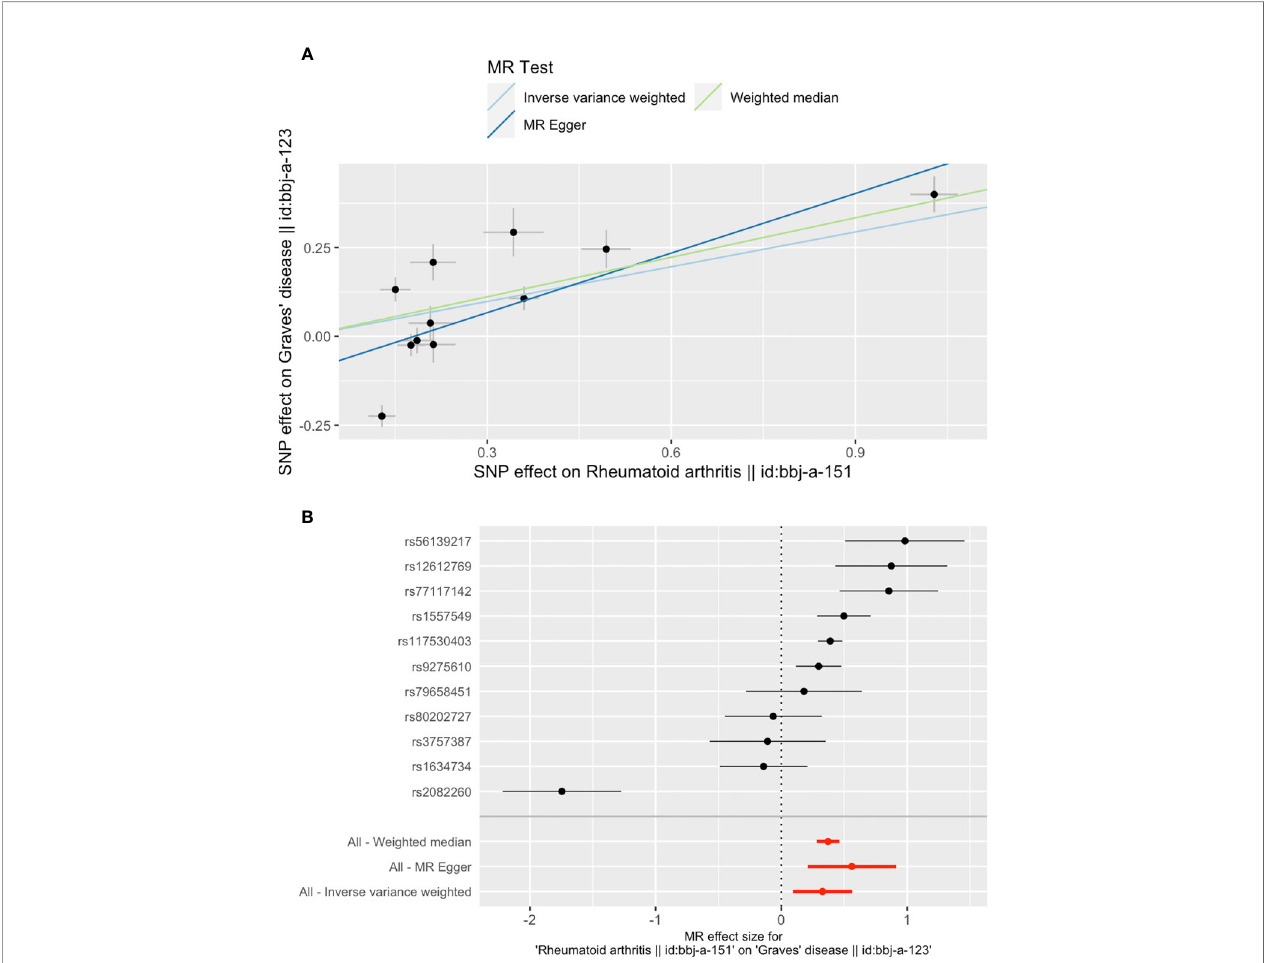
FIGURE 3 | Plots of Mendelian randomization (MR) estimates of the causal relationship between Graves ’ disease (GD) and rheumatoid arthritis (RA). The log odds ratio of risk is demonstrated, and three different methods [inverse variance weighted (IVW) approach, MR-Egger, and weighted median] were used. (A) The scattered plot of SNPs associated with RA and their risk on GD. (B) Forest plot of SNPs associated with RA and their risk on GD. SNPs, single nucleotide